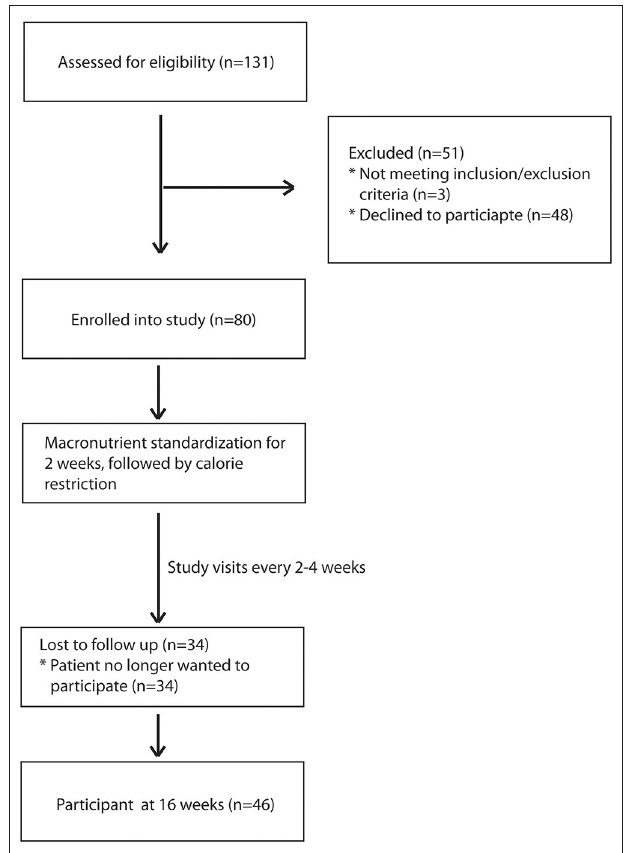
FIGURE 1 | Study flow diagram.